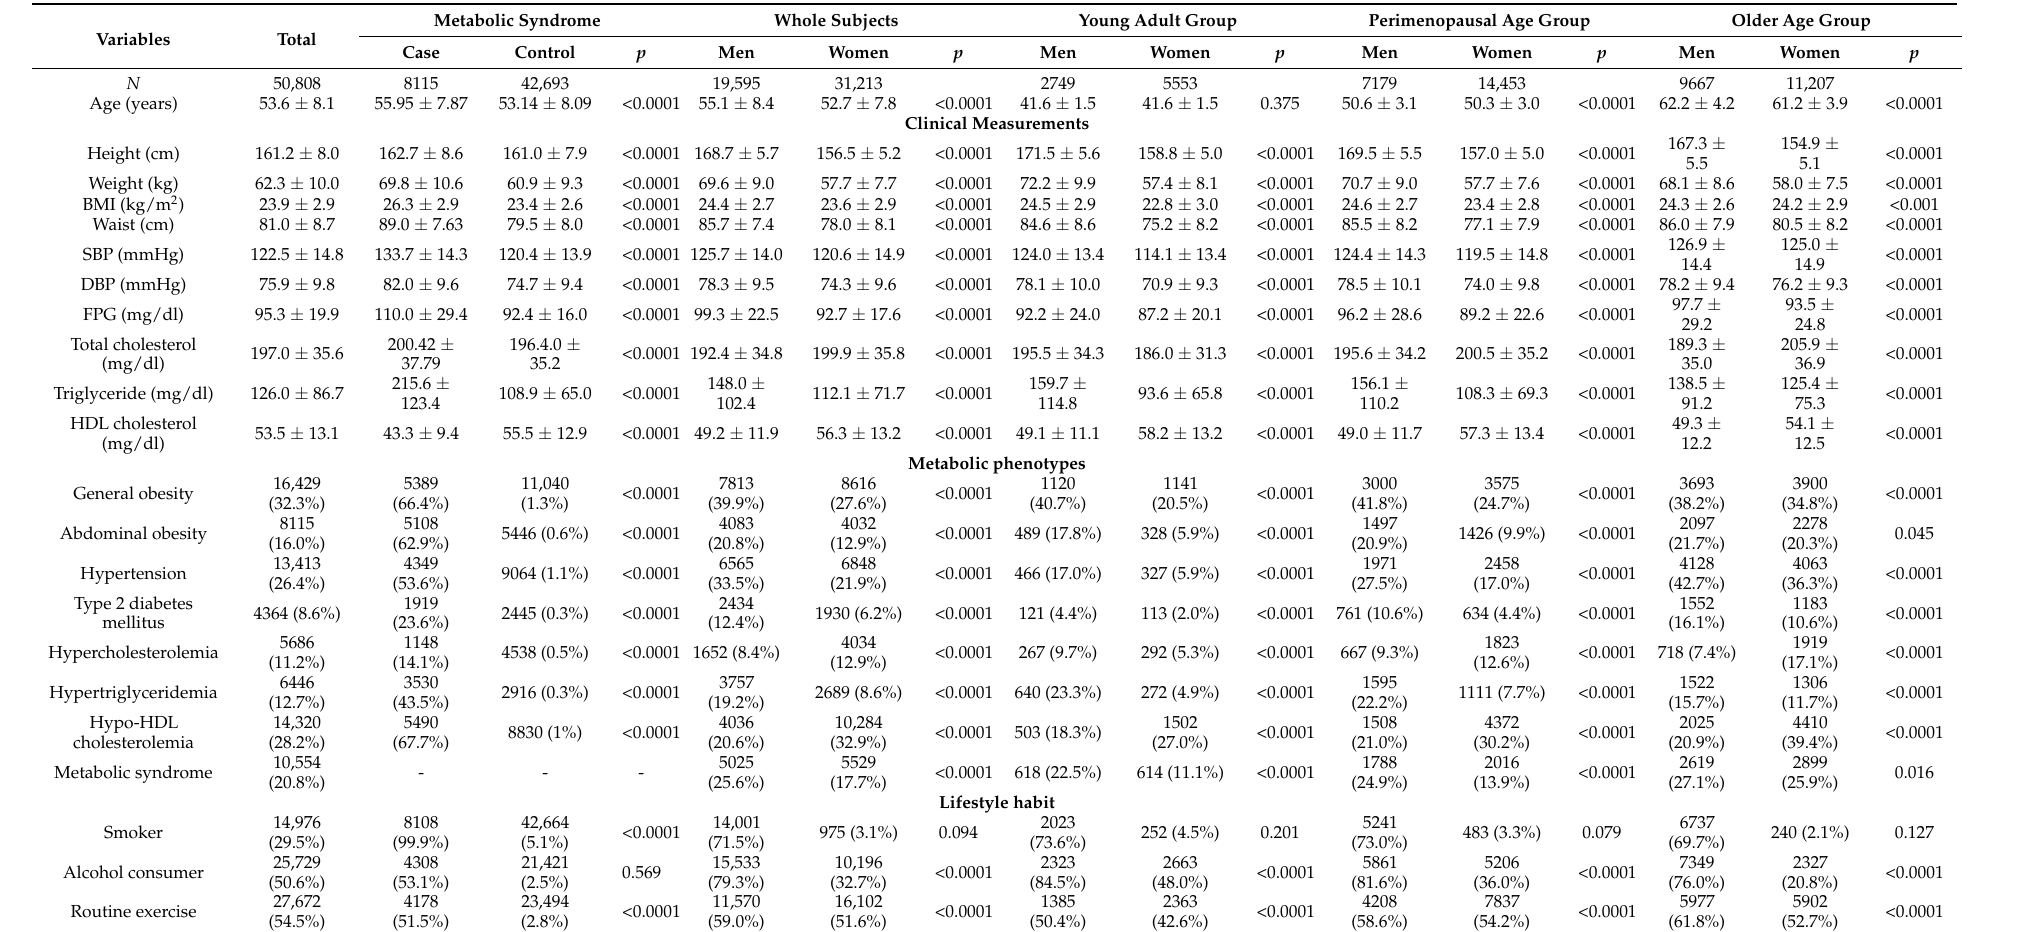
Table 1. General characteristics of the study